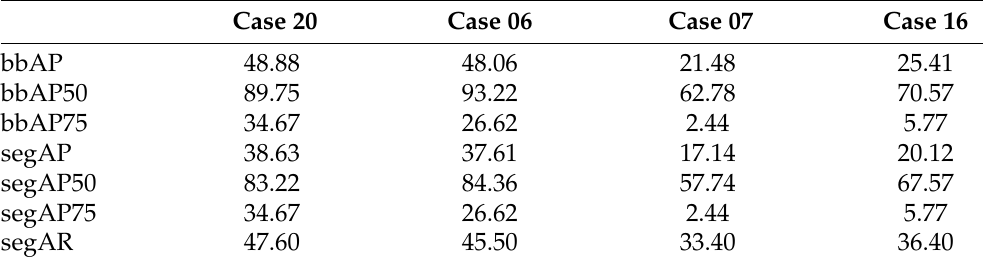
Table 2. Values (in percentage) for the Bounding Box (bb) and Segmentation (seg) Average Precision (normal, 50 and 5) and Average Recall (AR) for the Segmentation, for the best case scenarios (20 and 06) and worst case scenarios (07 and